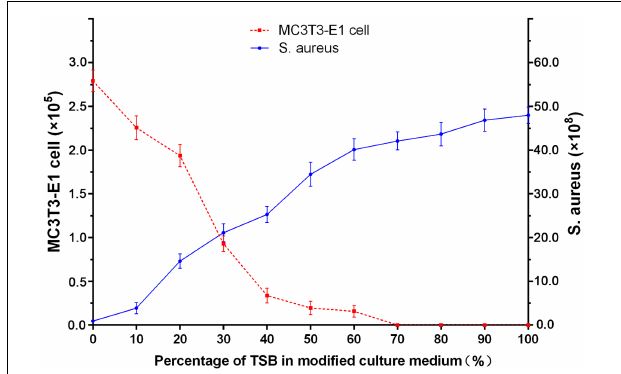
FIGURE 1 | Growth of MC3T3-E1 cells and S. aureus in varying ratios of standard cell medium to TSB after 24 h